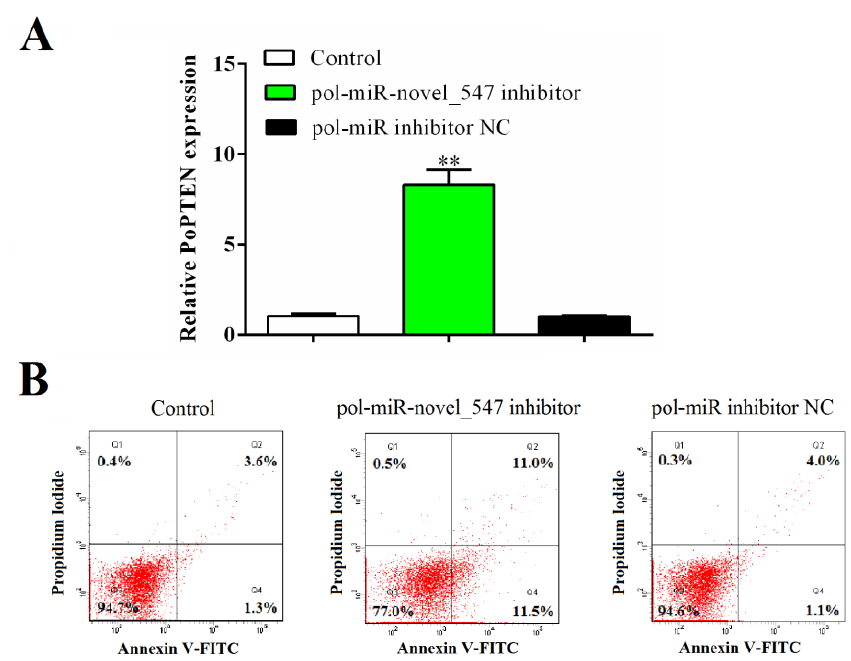
Figure 8. The e ff ect of PoPTEN on apoptosis. FG-9307 cells were transfected with or without (control) pol-miR-novel_547 inhibitor or pol-miR inhibitor NC for 24 h. ( A ) PoPTEN expression in the cells was determined by qRT-PCR. Values are the means of triplicate experiments and shown as means ± SEM. **, p < 0.01. ( B ) The transfected cells were labeled with annexin V-FITC and propidium iodide, and apoptosis was determined by flow cytometry.